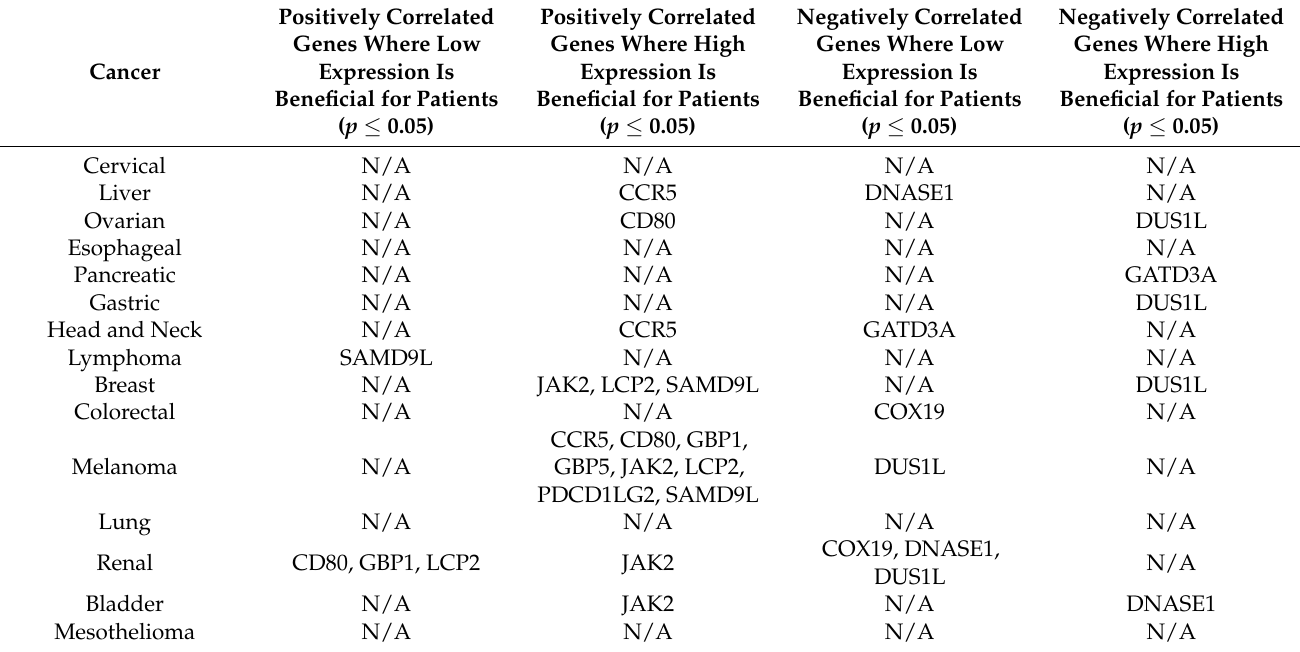
Table 2. Statistically significant Kaplan–Meier results for genes correlated with CD274. It should be noted that